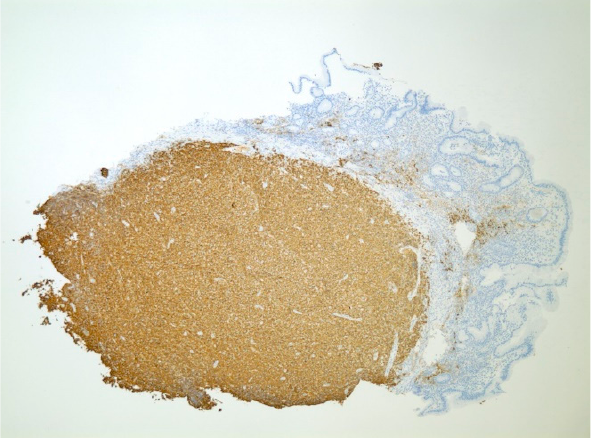
Figure 13. Immunohistochemical stain for CD20 showing diffuse positivity at 40× magnification. A 66-year-old female presented for endoscopic evaluation of progressive dysphagia to solids and liquids. CT scan showed a heterogeneous necrotic mass in the upper medi- astinum with sub-carinal and left hilar masses along with mass-effect and encasement of mediastinal structures as well. EGD showed a large eroding posterior mediastinal mass was seen starting 22 cm from incisors (Figure 14). Large amount of fluid/pus in the cavity which suctioned easily. The stomach had innumerable polypoid-appearing lesions with superficial ulcers/erosions (Figure 15). Antrum was relatively spared. Nodular duodenitis was seen in the examined portion of the duodenum. Gastric biopsies revealed changes consistent with malignant melanoma (Figure 16).